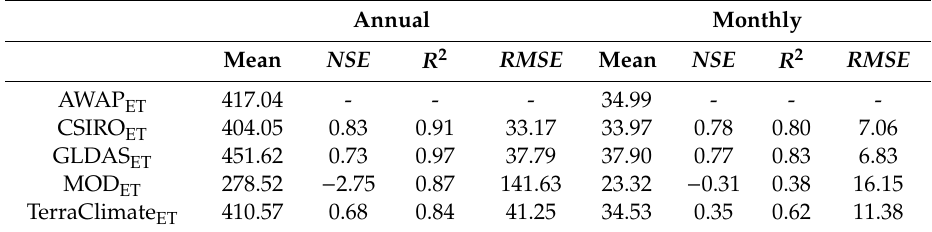
Comparison statistics of global evapotranspiration data products against AWAP evapotranspiration at the basin